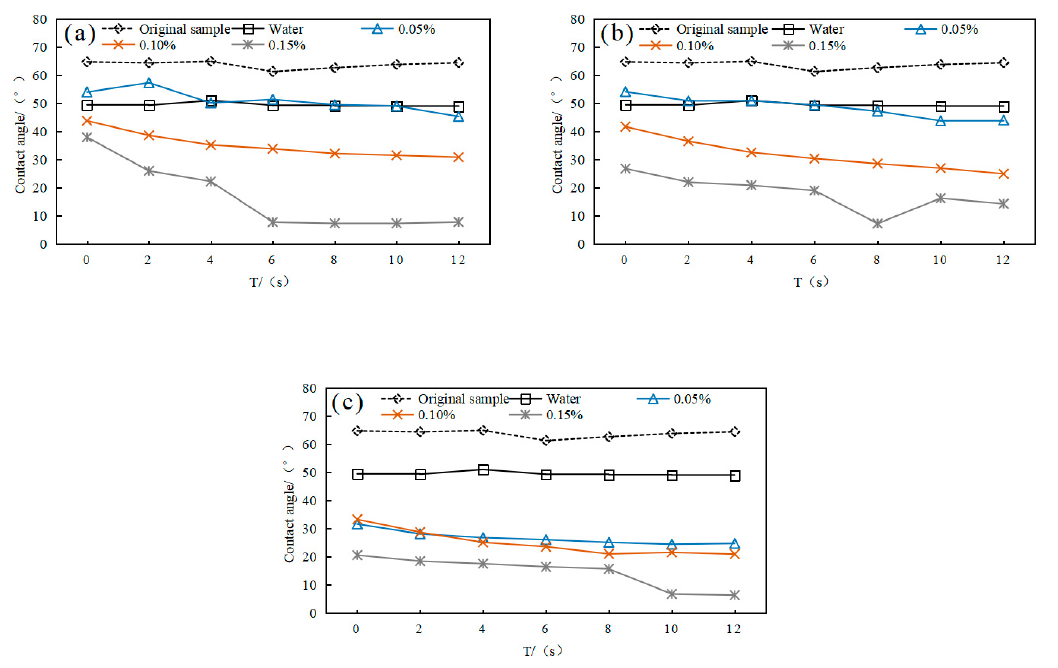
Figure 12. The contact angle variation of di ff erent concentrations ( a ) TX-10, ( b ) HSB1618 and